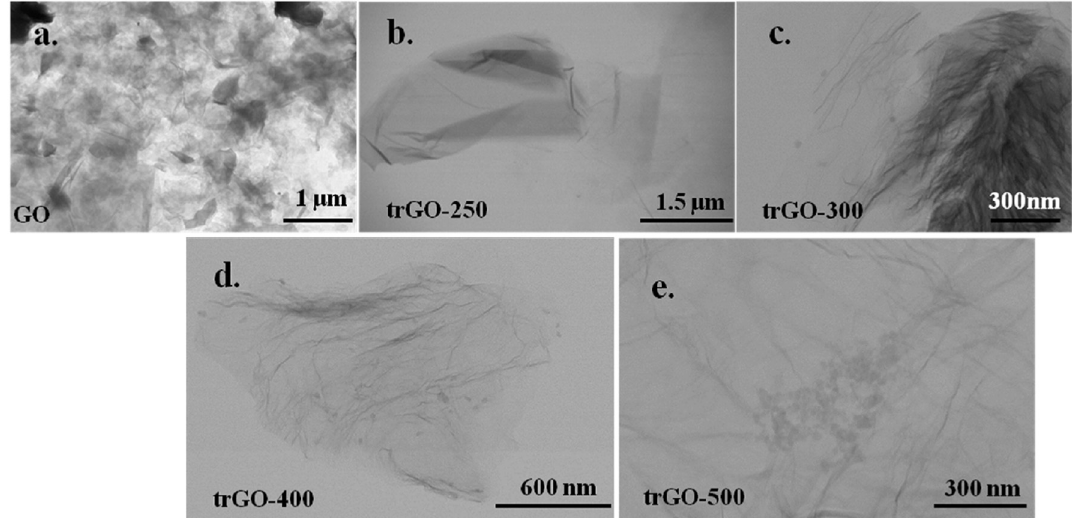
Figure 6. TEM images of ( a ) GO; and its reduction to r-GO at different temperatures: ( b ) 250 °C, ( c ) 300 °C, ( d ) 400 °C, and ( e ) 500 °C. Reproduced from Ref. [73] with permission from ELSEVIER.